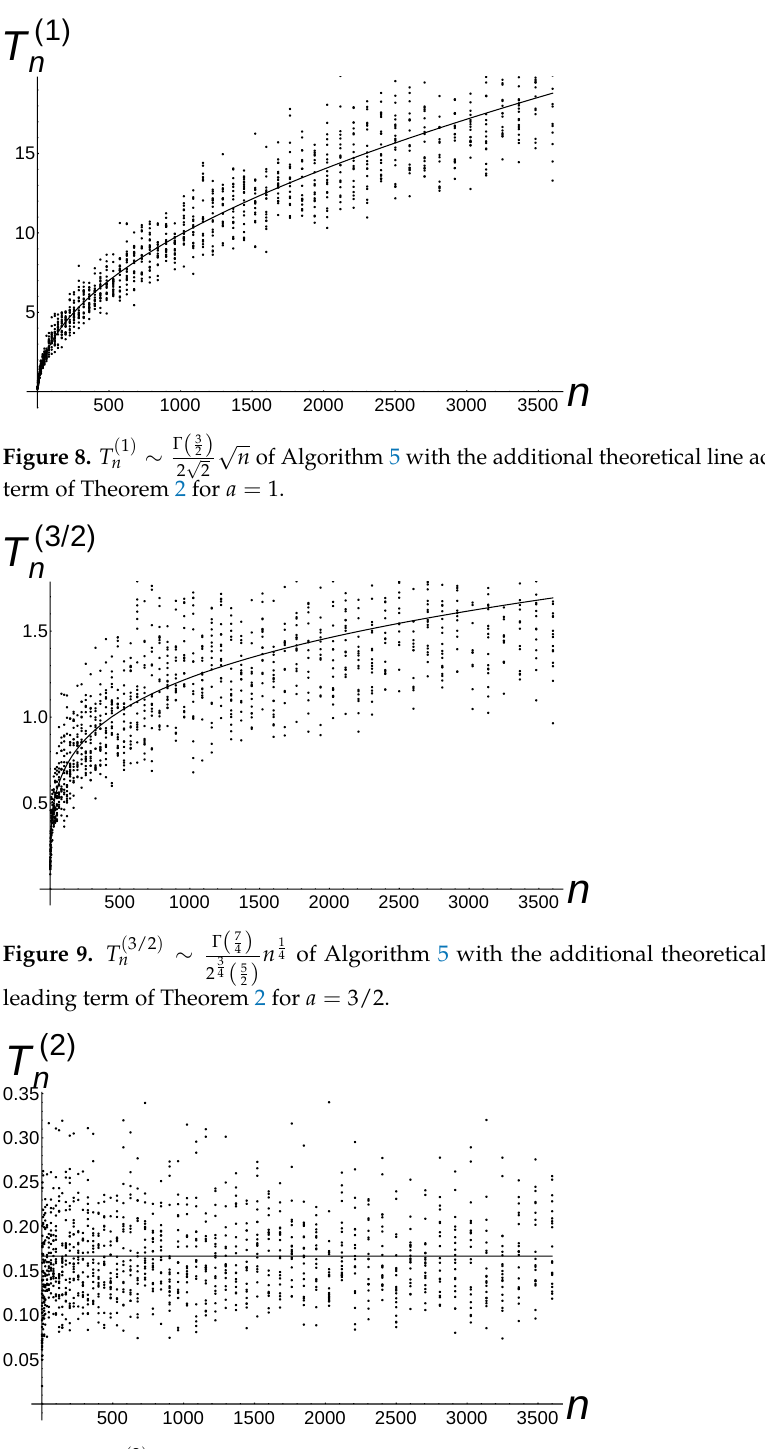
( 2 ) ∼ 1 Figure 10. T of Algorithm 5 with the additional theoretical line according to the leading term n 6 of Theorem 2 for a =